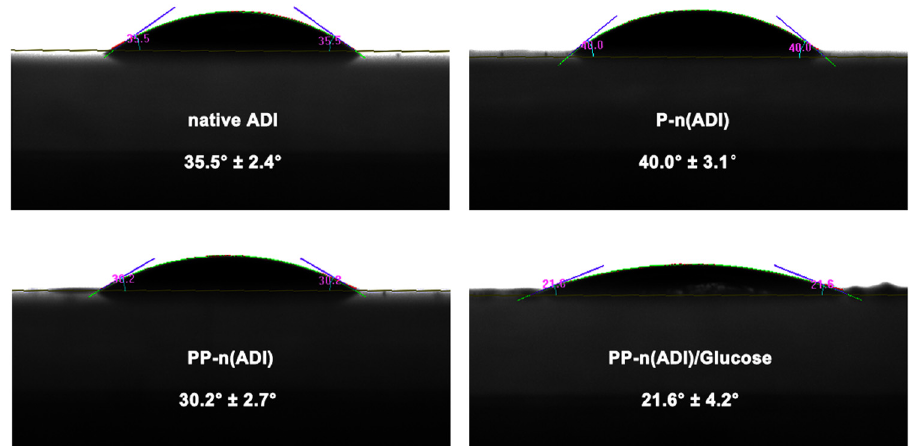
Figure 3: The fi lms were respectively formed by corresponding samples, and their water contact angle was